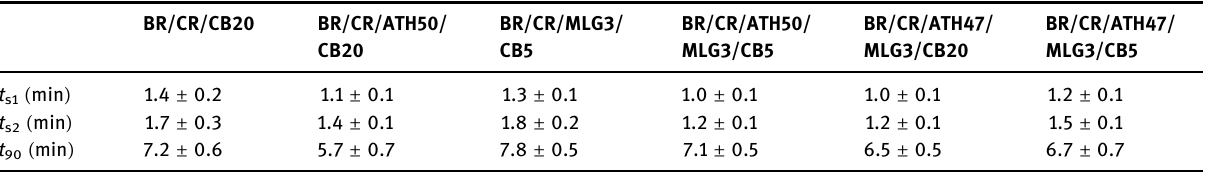
Table 2: Curing characteristics of BR/CR rubber